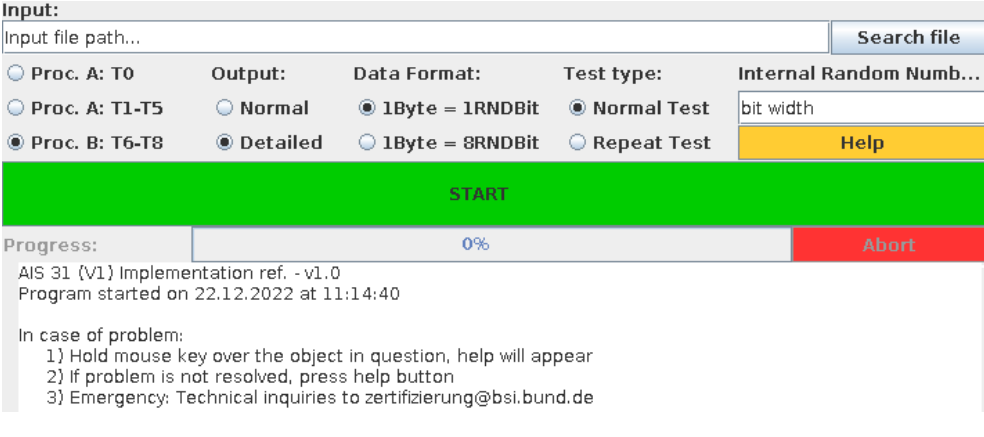
Figure 1. BSI tool for entropy